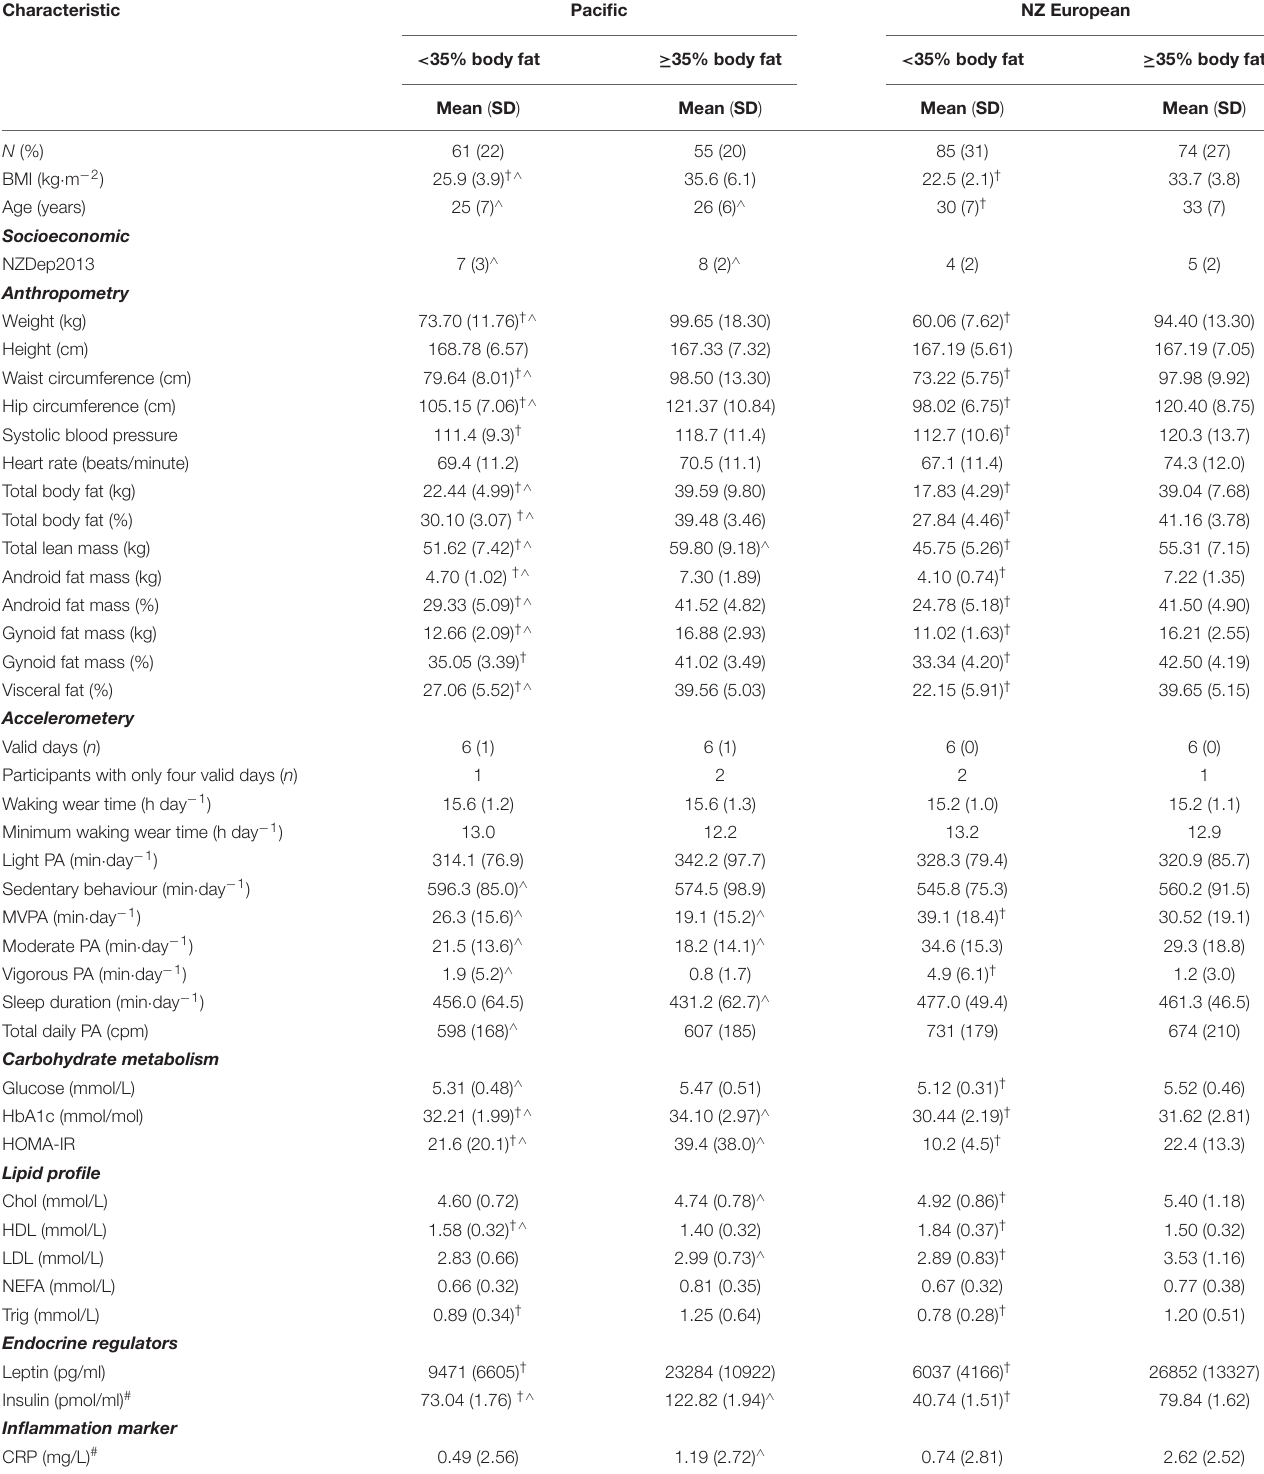
TABLE 1 | Characteristics and difference in anthropometry, accelerometery, dietary, socioeconomic, and endocrine by ethnicity and body fat% group.